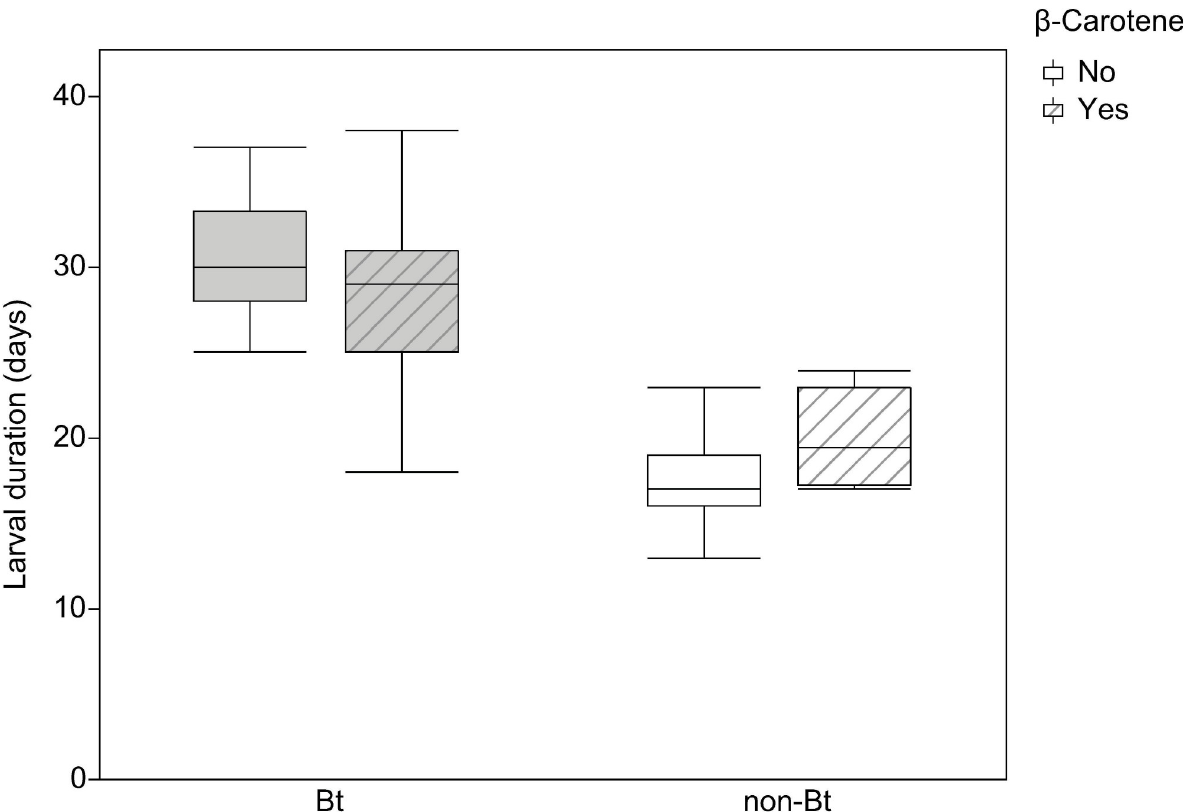
Fig 2. Development of Helicoverpa armigera F1 larvae. Effect of the addition of vitamin A ( β -carotene: 0 or 0.6% in weight) to non-Bt or Bt diets on F1 larval duration (in days) of Helicoverpa armigera . Bt (grey boxplot) indicates diets prepared with lyophilized leaves of Bt maize while non-Bt (white boxplot) indicates diets prepared with lyophilized leaves of non-Bt maize. Lined boxplots represent the addition of β -carotene to the diets while plots without lines represent diets without β -carotene. Statistical test: Two-way ANOVA ( P < 0.005), means were compared by the LS Means Student’s